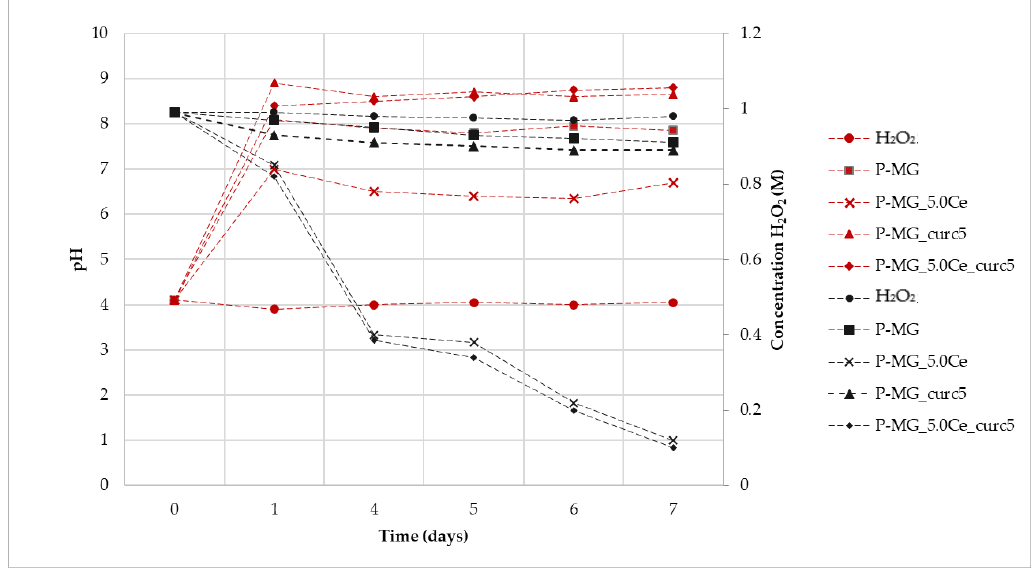
Figure 10. Variation of H 2 O 2 concentration mediated by samples (black) and variation of pH (red) during the assay time. Table 3. Linear equations and kinetic order of degradation in for each